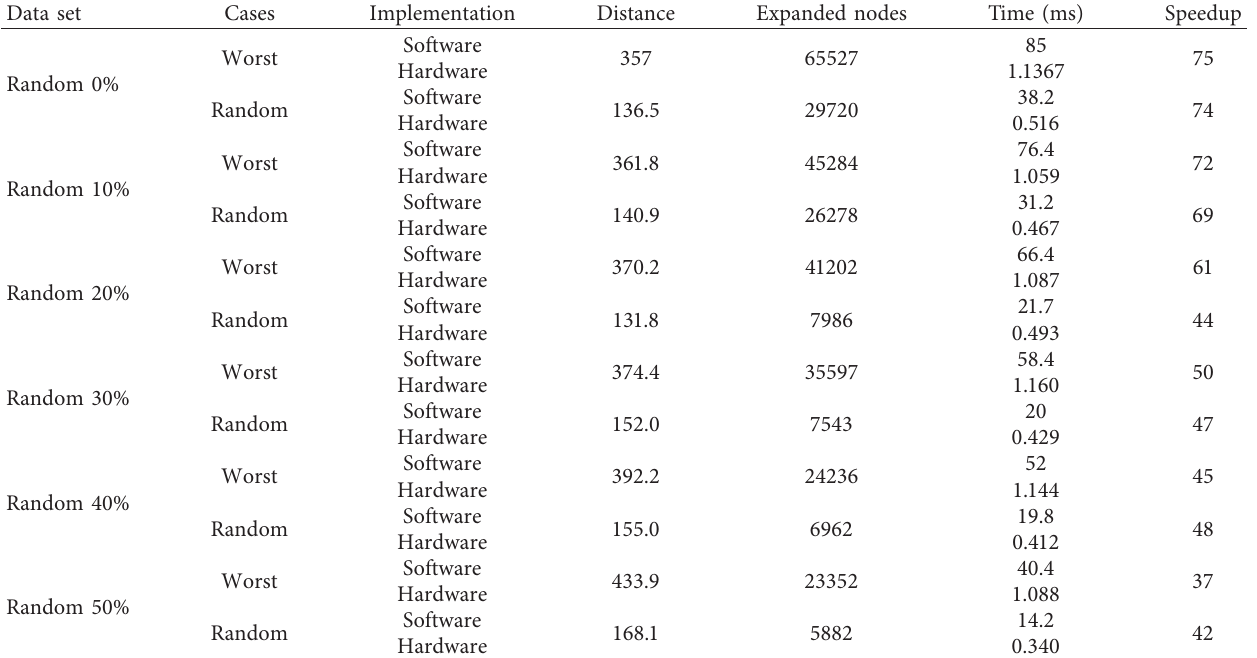
Table 5: Experimental results of randomly generated maps.